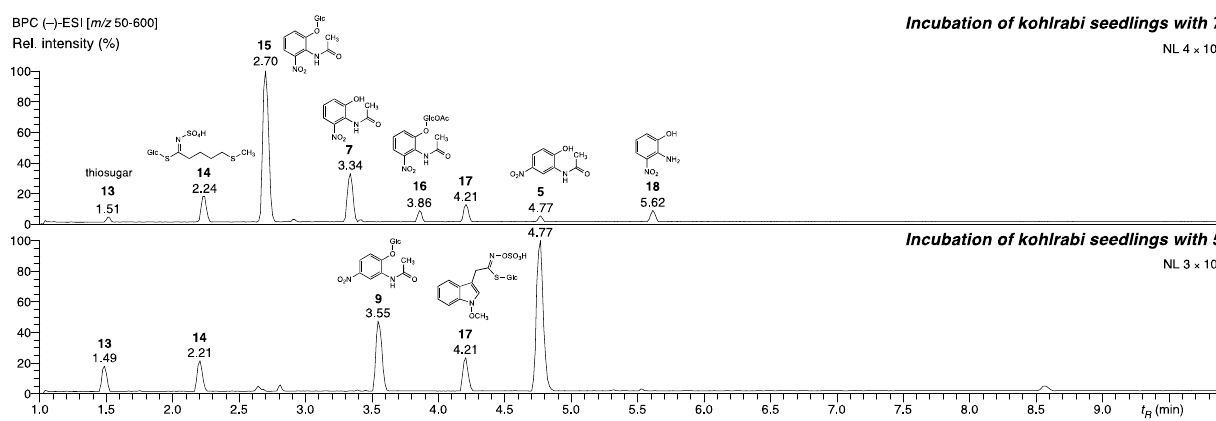
Figure 7. LC-(–)-ESI-HRMS chromatograms of kohlrabi root exudate extracts after incubation with 5 (bottom) and 7 (top). MS/MS data and annotation of the metabolites are presented in Table S4.